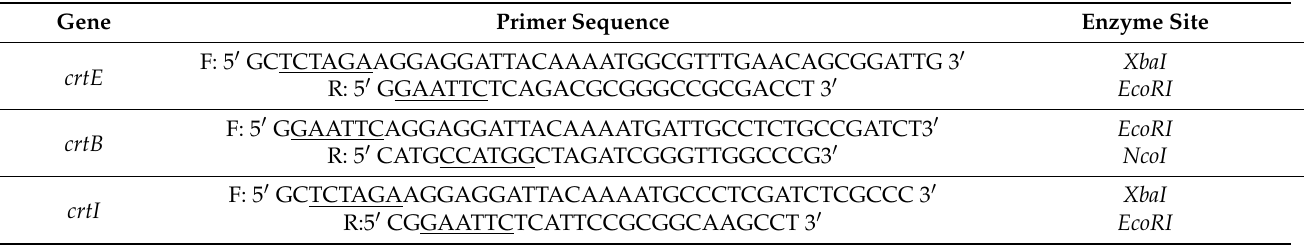
Table 3. Primers used in this study. The underlined sections indicate restriction enzyme sites. Gene Primer Sequence Enzyme